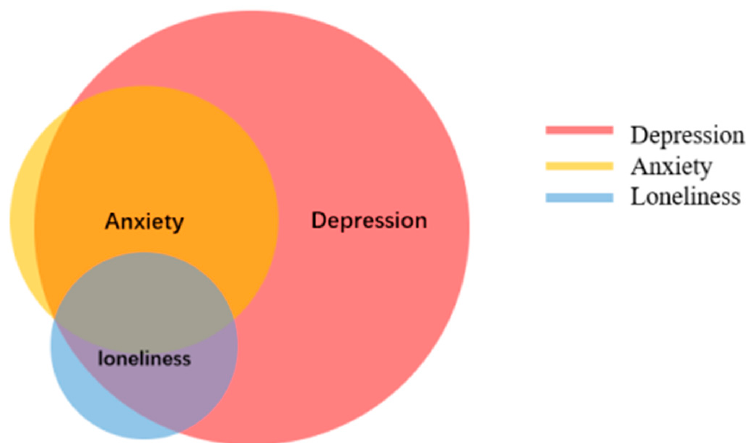
Lonely: ULS-8 score ≥ 24. Anxious, GAD-7 score ≥ 9, Depressed, GDS-15 score ≥ 5. 3.3. Comorbidity between Loneliness, Depression, and Anxiety Loneliness and depression are comorbid in 6.0% of the participants. Anxiety and loneliness have a 3.8% comorbidity. Additionally, 15.0% of participants experienced anxiety and depression. There are 3.8% of participants with all three of these negative psychological symptoms (Figure 1).